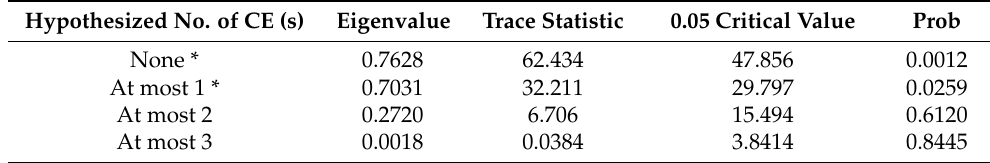
Table 3. Johansen Unrestricted Cointegration Rank Test (Trace). Hypothesized No. of CE (s)